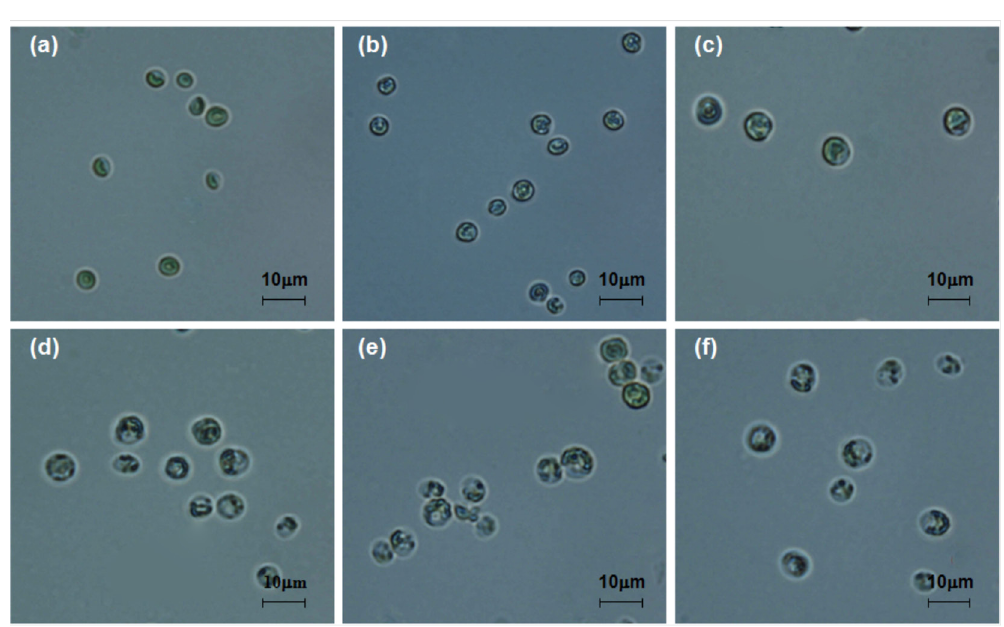
Fig. 2. Microscopic images of C. sorokiniana incubated in various TAP media, TAP (a), TAP-N (b), TAP-S (7 mM NH (c), TAP-S (0.7 mM NH